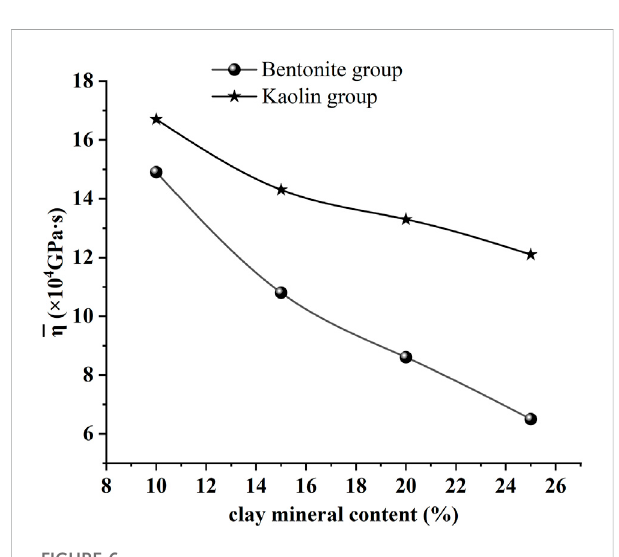
FIGURE 6 Average viscosity coef fi cient of different specimens. TABLE 5 Content of adsorbed water of each sample ( W g ≈ 0 . 885 W P ; W a ≈ W L ). No.